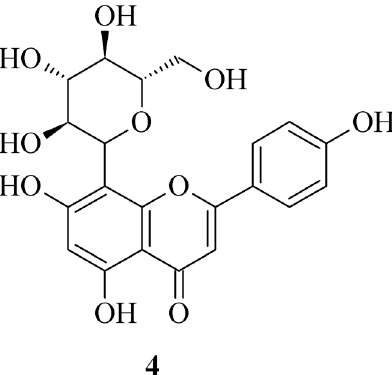
Figure 3 -The flavonoid vitexin ( 4 ), from the Passiflora incarnata extract, and one of the compounds present in the herbal medicine Sintocalmy ®